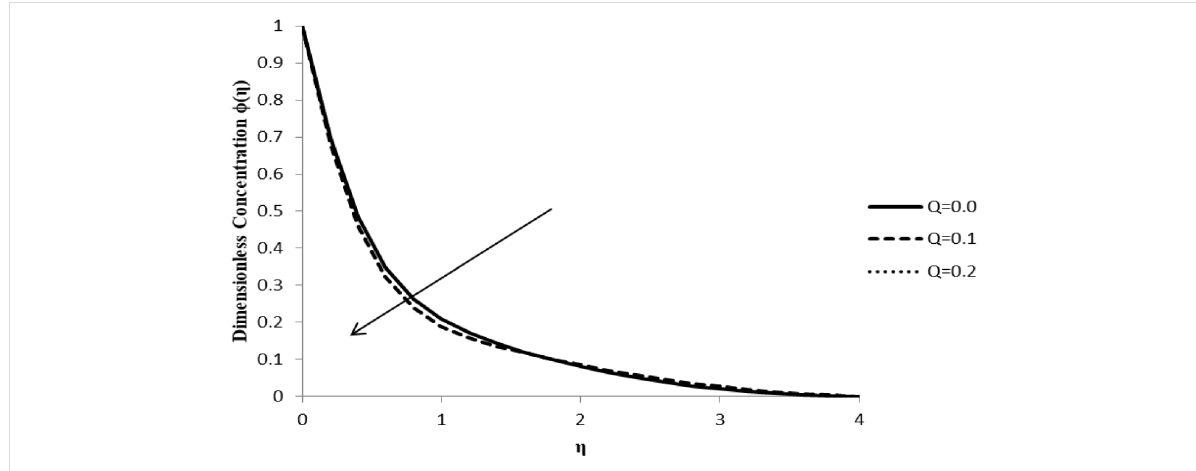
Figure 17: Influence of the heat generation/absorption coefficient Q on the concentration distribution ϕ ( η ) when n = 2.0, Pr = 2.0, Nb = Nt = 0.5, M = 0.0, Le = 5.0, F w = 0.2, and ξ =